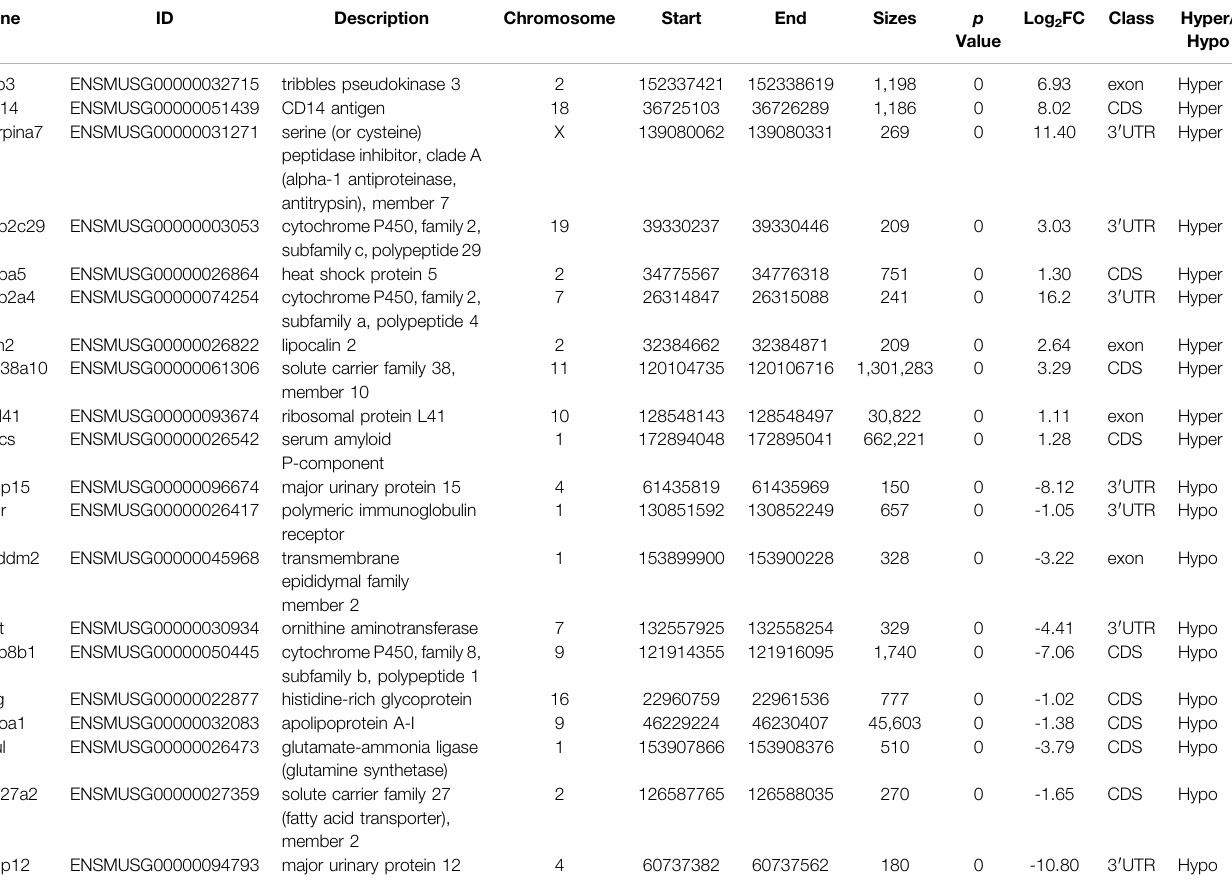
TABLE 1 | the top 10 hypermethylation genes and top 10 hypomethylation genes. Gene ID Description